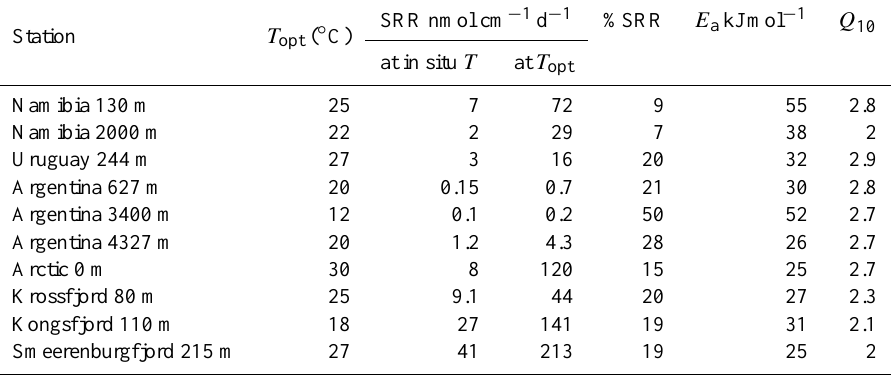
Table 3. Sulfate reduction activities and Arrhenius parameters determined in the temperature-gradient incubation experiments for Namibian, Uruguayan, Argentine and Arctic